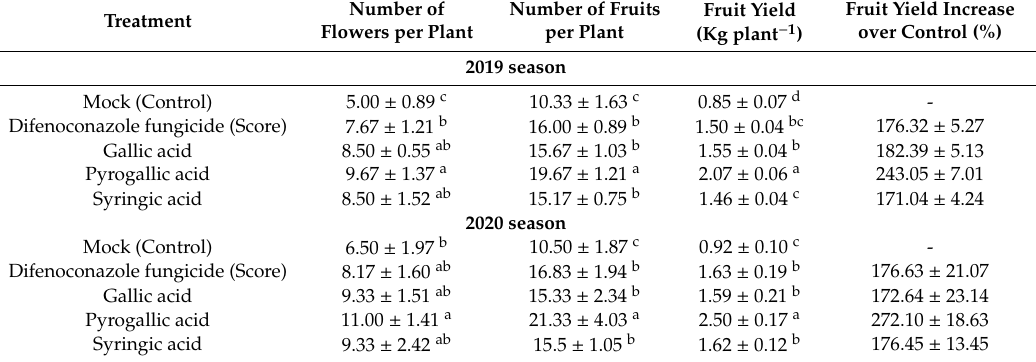
Table 3. E ff ects of gallic acid and its derivatives on yield components of tomato plants (Super strain B–F 1 hybrid) infected with A. solani under greenhouse conditions during 2019 and 2020 seasons ( n =